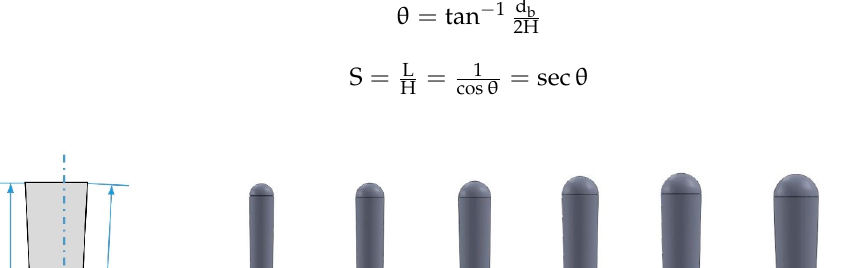
Figure 6b. The calculation results of the effective thermal conductivity are presented in Figure 7, in which there was a decline of the effective thermal conductivity as the diameter of the coarse column increased. Performing polynomial fitting on the curve in Figure 7b, the function of effective thermal conductivity and column head diameter could be ob- tained, as shown in the following Formula (7). The specific fitting parameters are shown in Figure 7b.